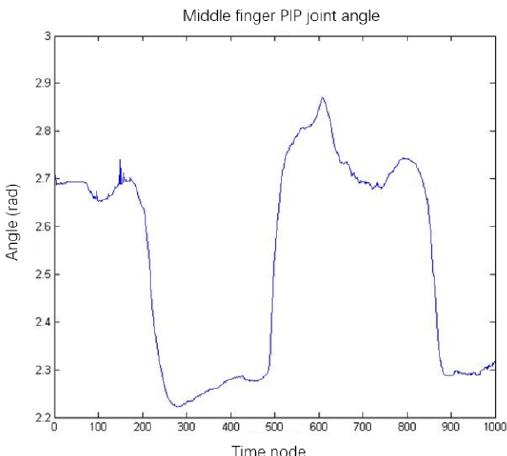
Figure 13. Middle finger PIP joint angle.